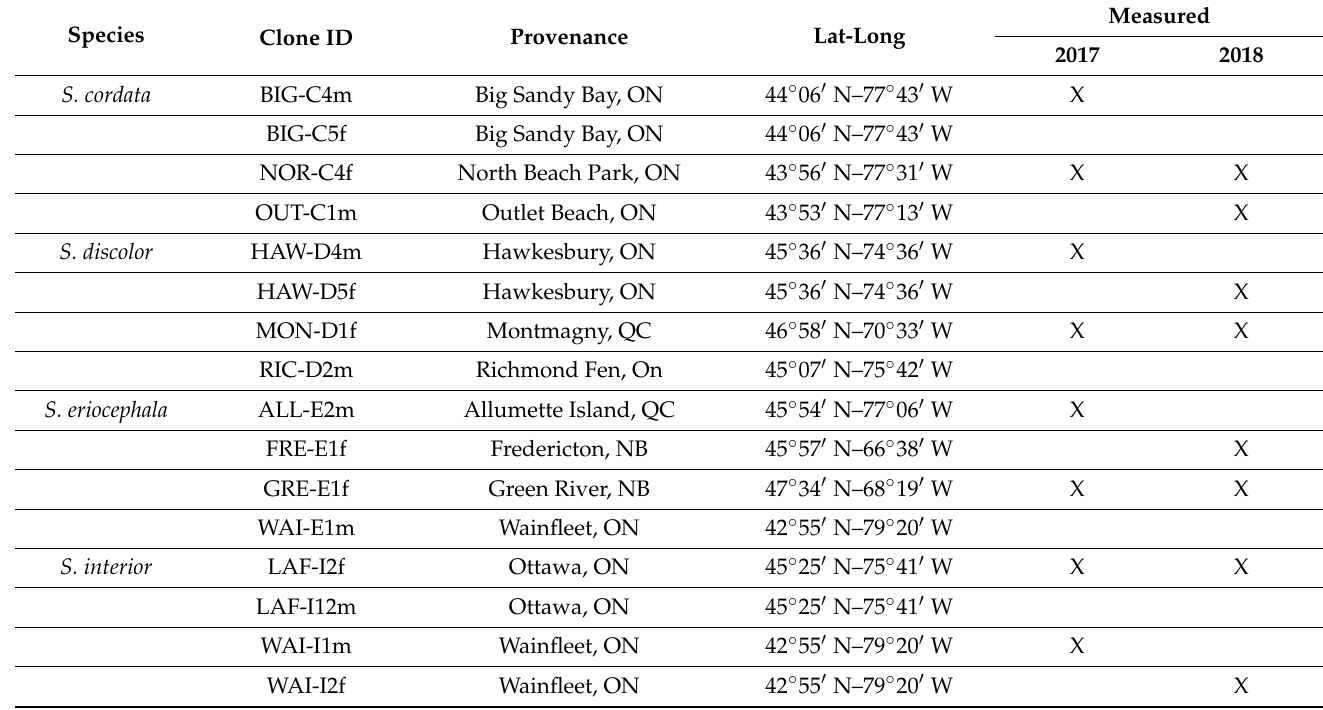
Table 1. Species and clones of Salix used in 2017 CO 2 × soil moisture and 2018 CO 2 × fertiliza- tion